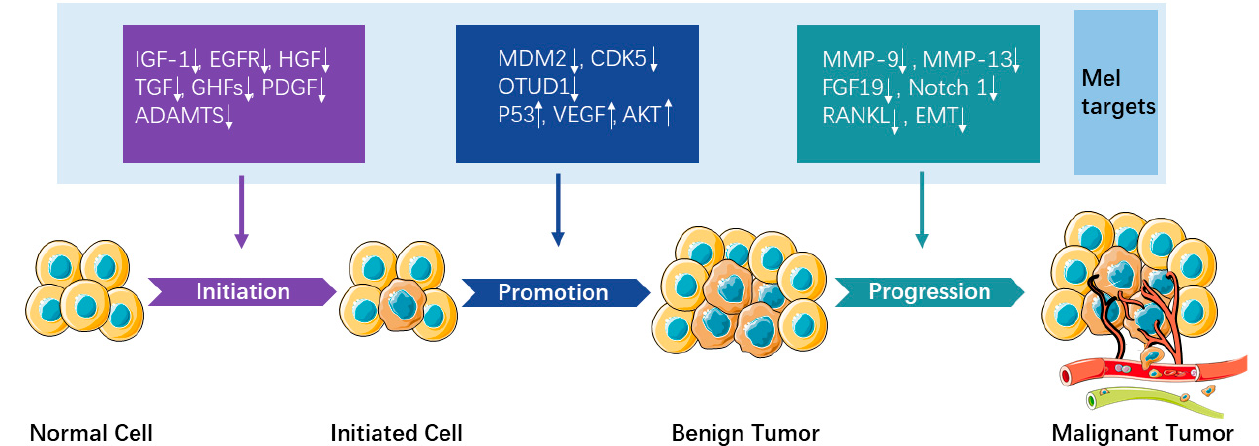
Figure 1. The anticancer effect of melatonin and the involved signaling pathways on tumor initiation, promotion, and progression phases. Up arrows represent upregulation ( ↑ ), down arrows represent downregulation ( ↓ ).